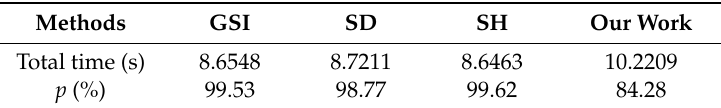
Table 4. Total computational time comparison. p denotes the percentage of the normal estimation step to the total processing